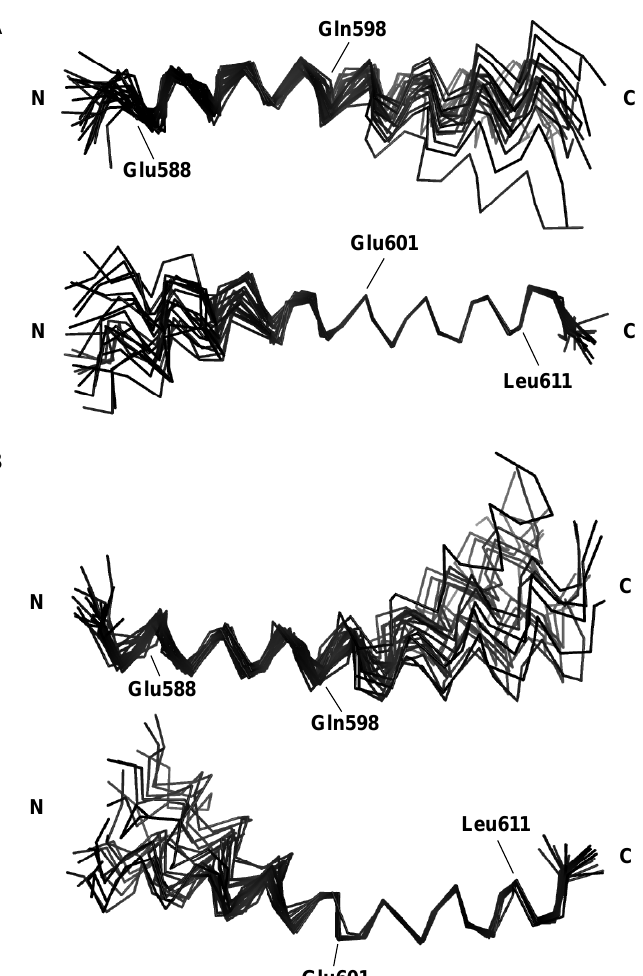
Figure 4. Conformations of AQEE-30 ( A ) in the HFIP solution and ( B ) in the DPC micelle solution. The structures have been solved with NMR spectra and the structure calculations were done using CYANA. Twenty models are represented for HFIP and DPC, respectively. Only the backbone is represented for clarity. The molecules were superimposed in the N-terminal region from 588 Glu to 598 Gln (upper side) and the C-terminal amphiphilic region from 601 Glu to 611 Leu (lower side) for HFIP and DPC, respectively. Boundary residues, 588 Glu and 598 Gln of the N-terminal region, 601 Glu and 611 Leu of the C-terminal amphiphilic region and termini are indicated. In both the HFIP and DPC micelle solutions, AQEE-30 showed α -helical structures in most of the residues. When 20 models of AQEE-30 in the HFIP solution were aligned in the C-terminal region from Glu 601 to Leu 611 , the backbone root-mean-square deviation (RMSD) value was 0.08, which demonstrates that this region converged well (Figure 4A). However, when aligned in the N-terminal region from Glu 588 to Gln 598 , the backbone RMSD value was 0.90, showing less convergence. The backbone RMSD value from the full sequence was 1.61. Similarly, the ensemble of structures of AQEE-30 in the DPC micelle solution was converged well in the C-terminal region but showed less convergence in the N-terminal region. When 20 models of AQEE-30 in the DPC micelle solution were aligned in the C-terminal region from Glu 601 to Leu 611 , the backbone RMSD value was 0.23 (Figure 4B). However, when aligned in the N-terminal region from Glu 588 to Gln 598 , the backbone RMSD value was 0.76 and the backbone RMSD value from the full sequence was 1.72. The N-terminal region of AQEE-30 was flexible compared with the C-terminal region in both the HFIP and DPC micelle solutions. This result suggests that AQEE-30 can have